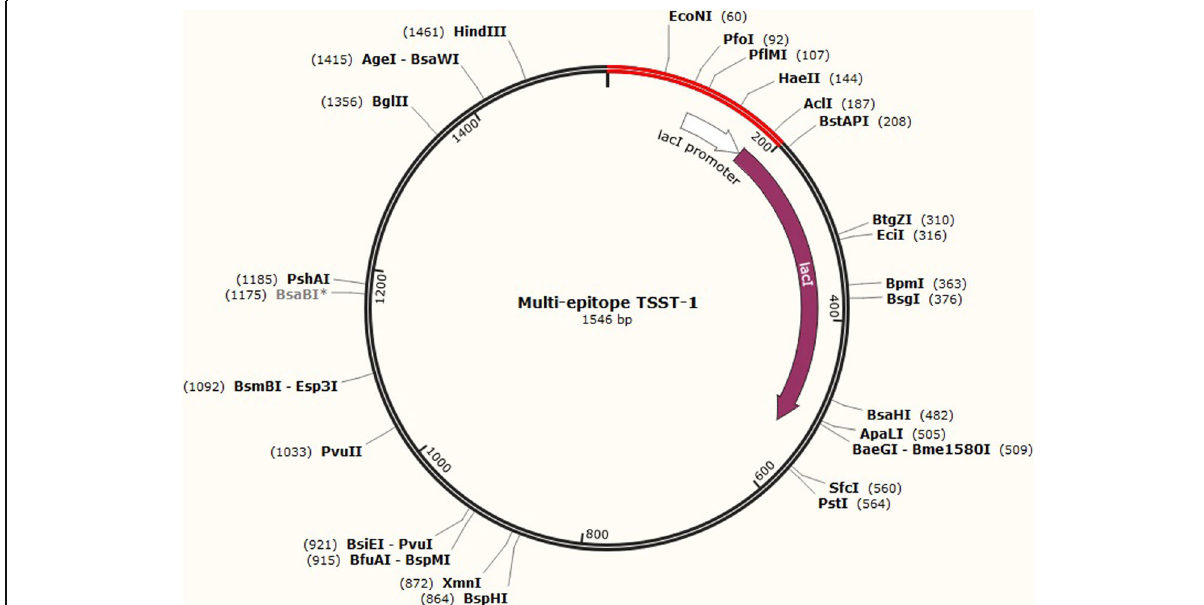
Fig. 9 In silico cloning of gene coding (red color) for the vaccine construct in to pET28a (+)